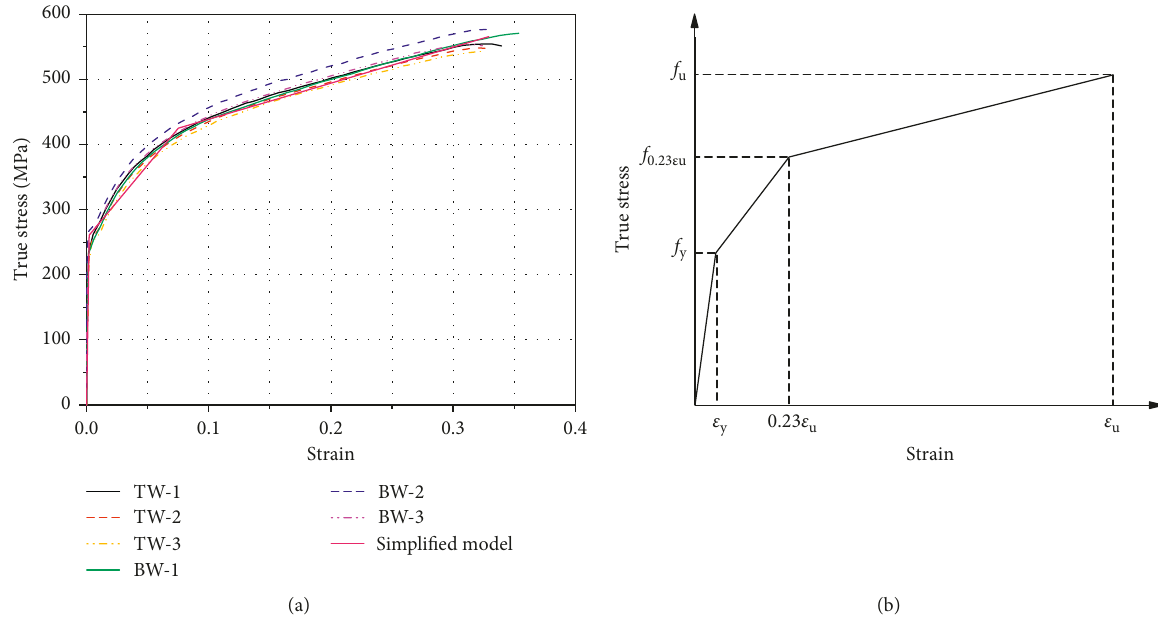
Figure 14: Simplified model of true stress-strain curve of the flat region: (a) features of true stress-strain curves of the flat region; (b) trilinear constitutive model with two-stage strain hardening for the flat